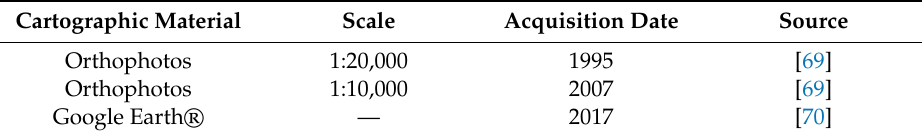
Table 3. Support cartographic material for training sites